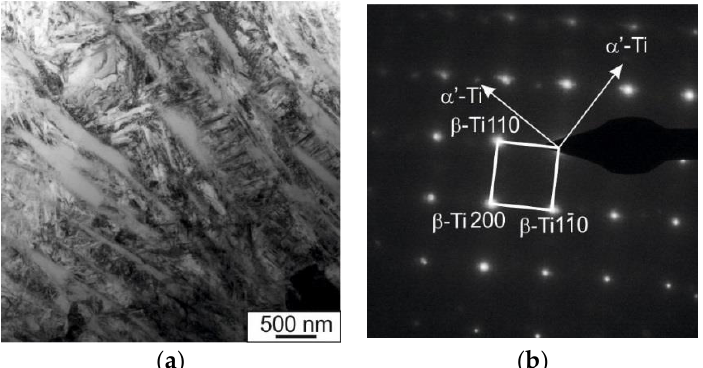
Figure 7. Results of TEM investigations of the vortex zone: ( a ) the structure of a vortex; ( b ) electron diffraction pattern obtained from the area shown in ( a ).